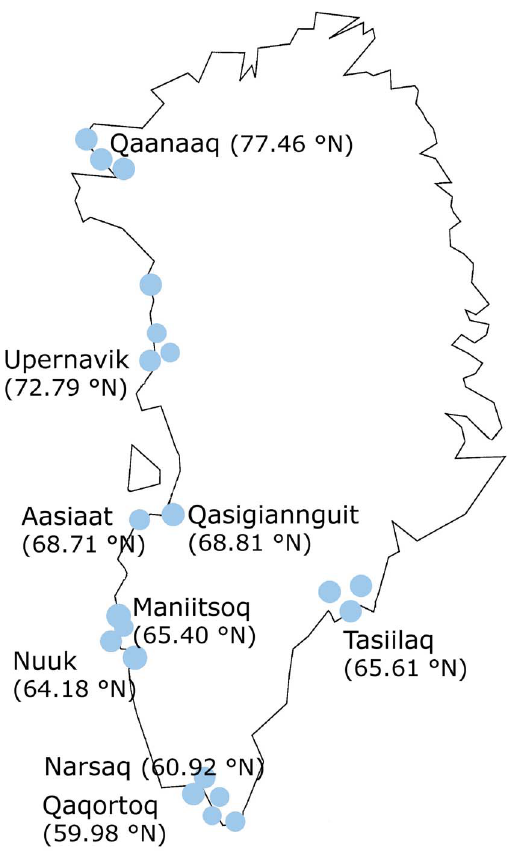
Figure 1. Map of Greenland. The map shows the 9 towns and appurtenant villages where the study participants were